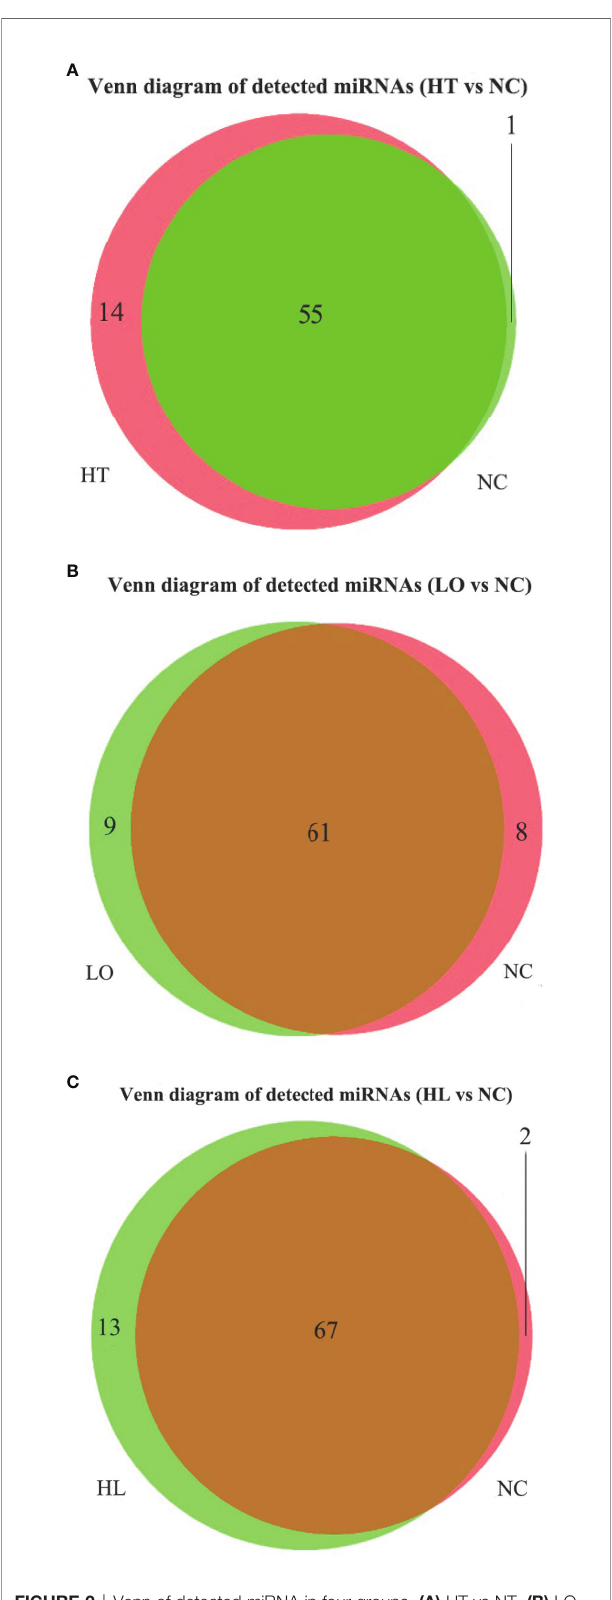
FIGURE 2 | Venn of detected miRNA in four groups. (A) HT vs NT, (B) LO vs NT, (C) HL vs